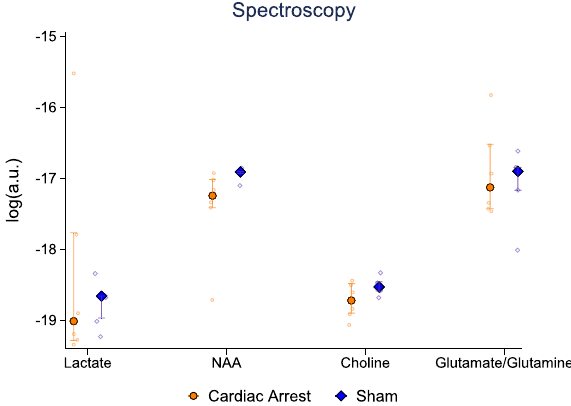
Fig. 6 MR spectroscopy with concentrations (in arbitrary units) for four metabolites from a whole brain voxel. Y -axis is presented on log 10 scale. Data are presented as median [25–75%] with overlaid scatter plots representing each animal. NAA N -acetylaspartate, a.u. arbitrary